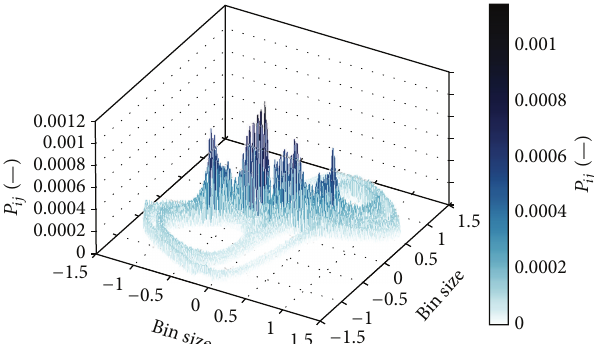
Figure 1: Joint probability matrix, PS projection for the Lorenz-like Shimizu-Morioka model at 𝜏 MIF . min